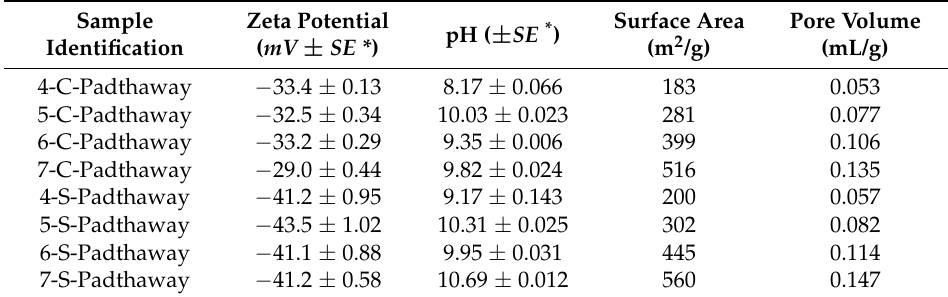
Table 1. Grapevine biochar physical properties.